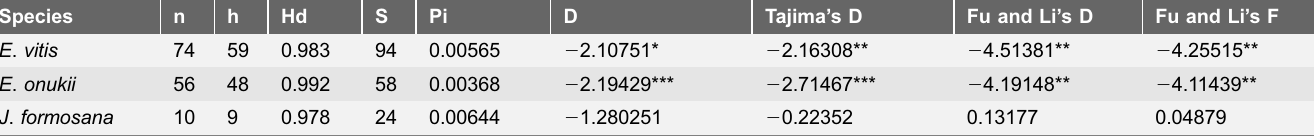
Table 2. Comparison of combined COI and 16sRNA sequences evolution of E . vitis , J . formosana and E . onukii . Species